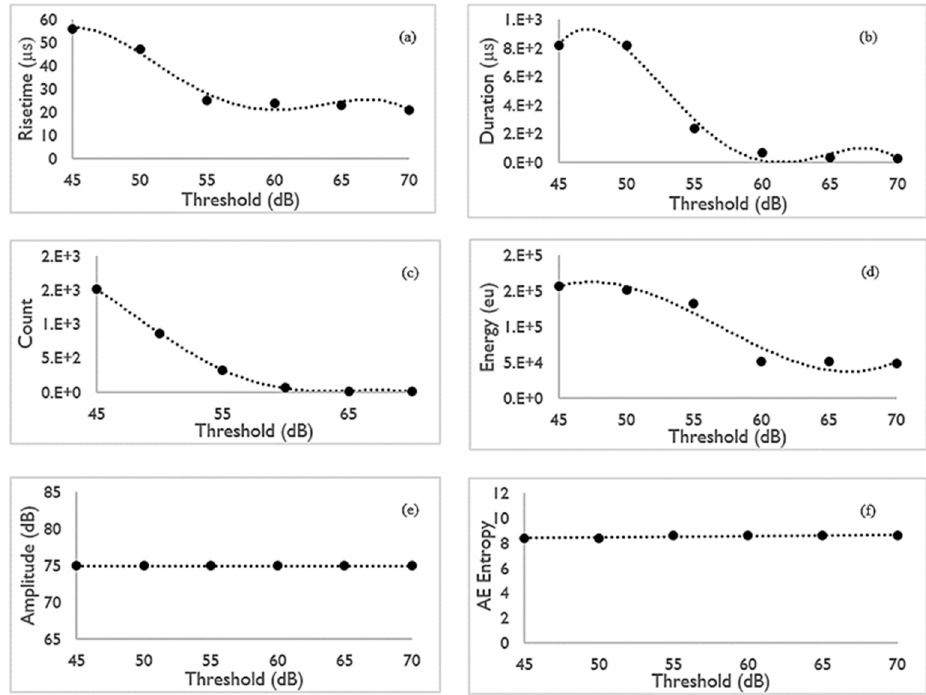
Figure 12. Influence of acquisition threshold on waveform generated from the pencil lead break (PLB) test: ( a ) rise-time, ( b ) duration, ( c ) count, ( d ) energy, ( e ) peak amplitude and ( f ) AE entropy.